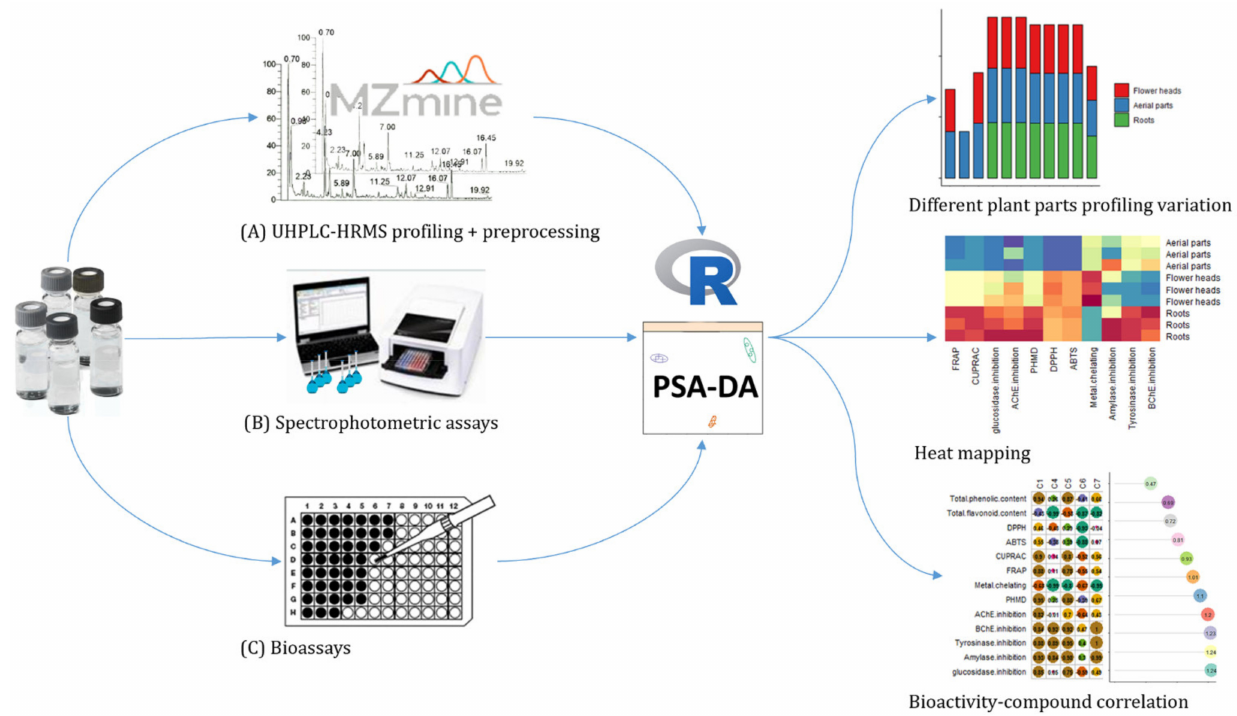
Figure 1. The complete workflow for the biochemometric approach. Samples (flower heads, aerial parts and root extracts) prepared at the same concentration are first injected into UHPLC–HRMS ( A ). Data are acquired using the data-dependent acquisition mode, then converted through MZmine 2 software processing. In parallel, spectrophotometric assays ( B ) and bioassays ( C ) are conducted to determine total phenolic and flavonoid contents and activity and information are tabulated. The final .csv files are then used for the generation of the biochemometic data by partial least-square discriminant analysis (PLS-DA) with R software. Finally, bioactivity mapping was